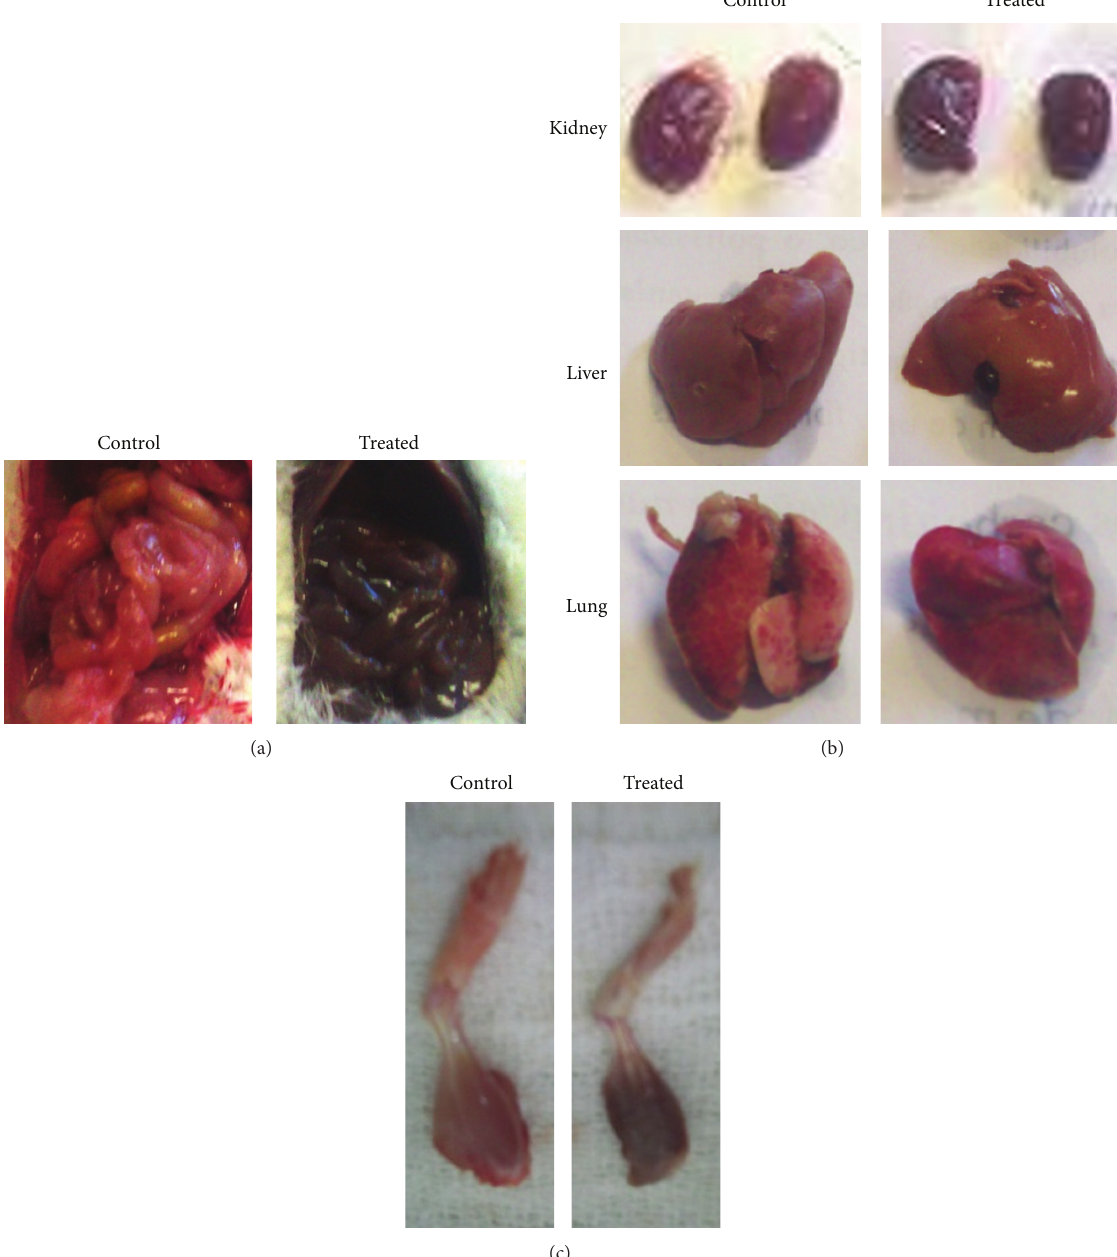
Figure 1: Abdominal cavity and organs of mice acutely or subchronically exposed to different diphenyl ditelluride treatments: (a) abdominal cavity of control (left) and diphenyl ditelluride (right) treated mice; (b) kidneys, liver, and lungs of control (left) and diphenyl ditelluride (right) treated mice; (c) muscles of lower limbs of control (left) and diphenyl ditelluride (right) treated mice. The picture is a representation of three independent experiments in all doses